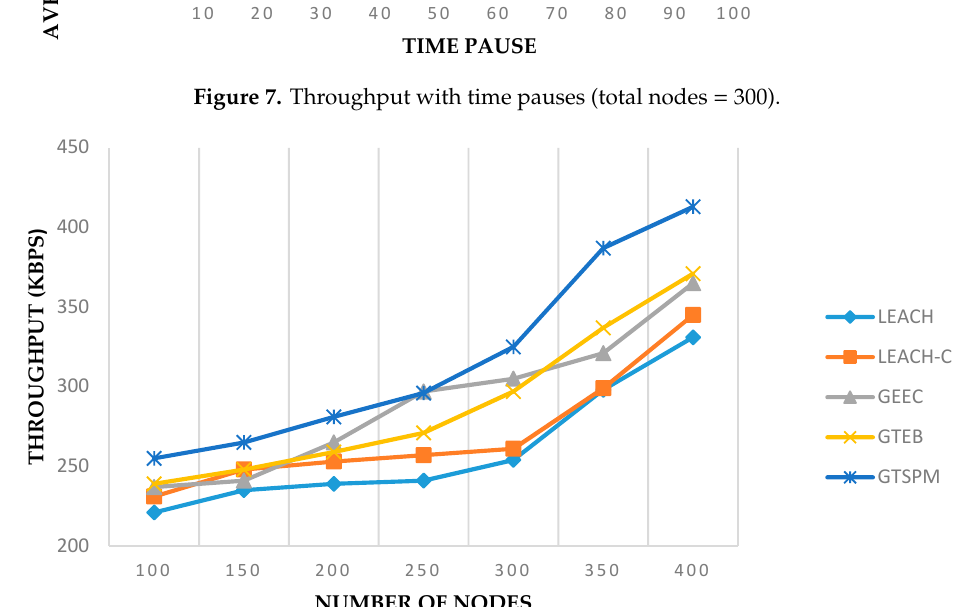
Figure 8. Throughput with varying network size (pause time = 90).